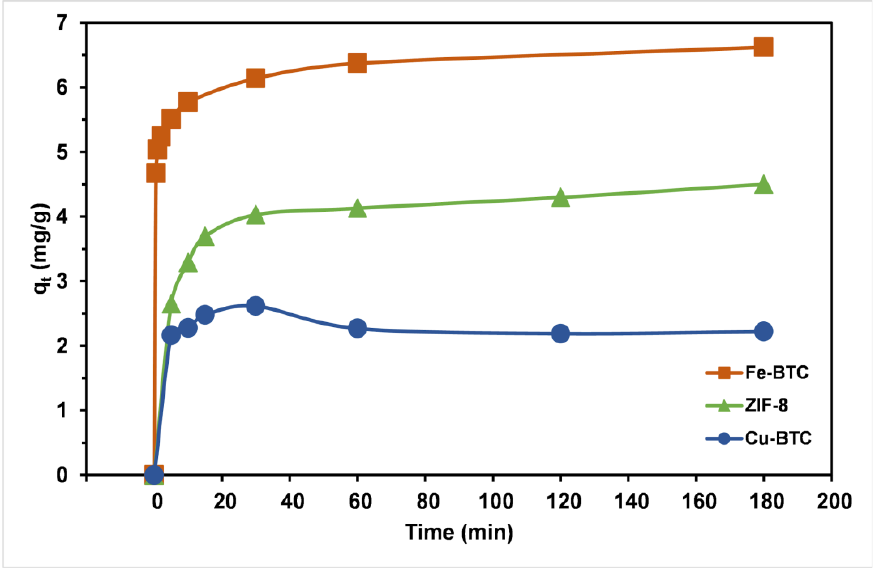
Figure 6. Comparison of MO removal efficiency of Fe-BTC, Cu-BTC, and ZIF-8 ( m = 100 mg, C o = 15 mg/L, pH = 6).